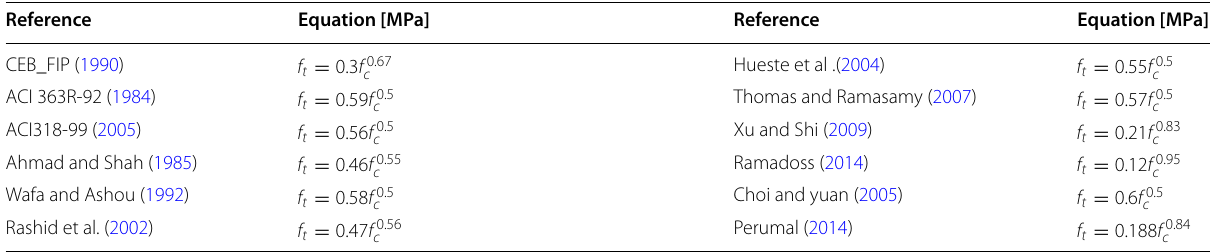
f c The cylindrical compressive strength of plain concrete (MPa)